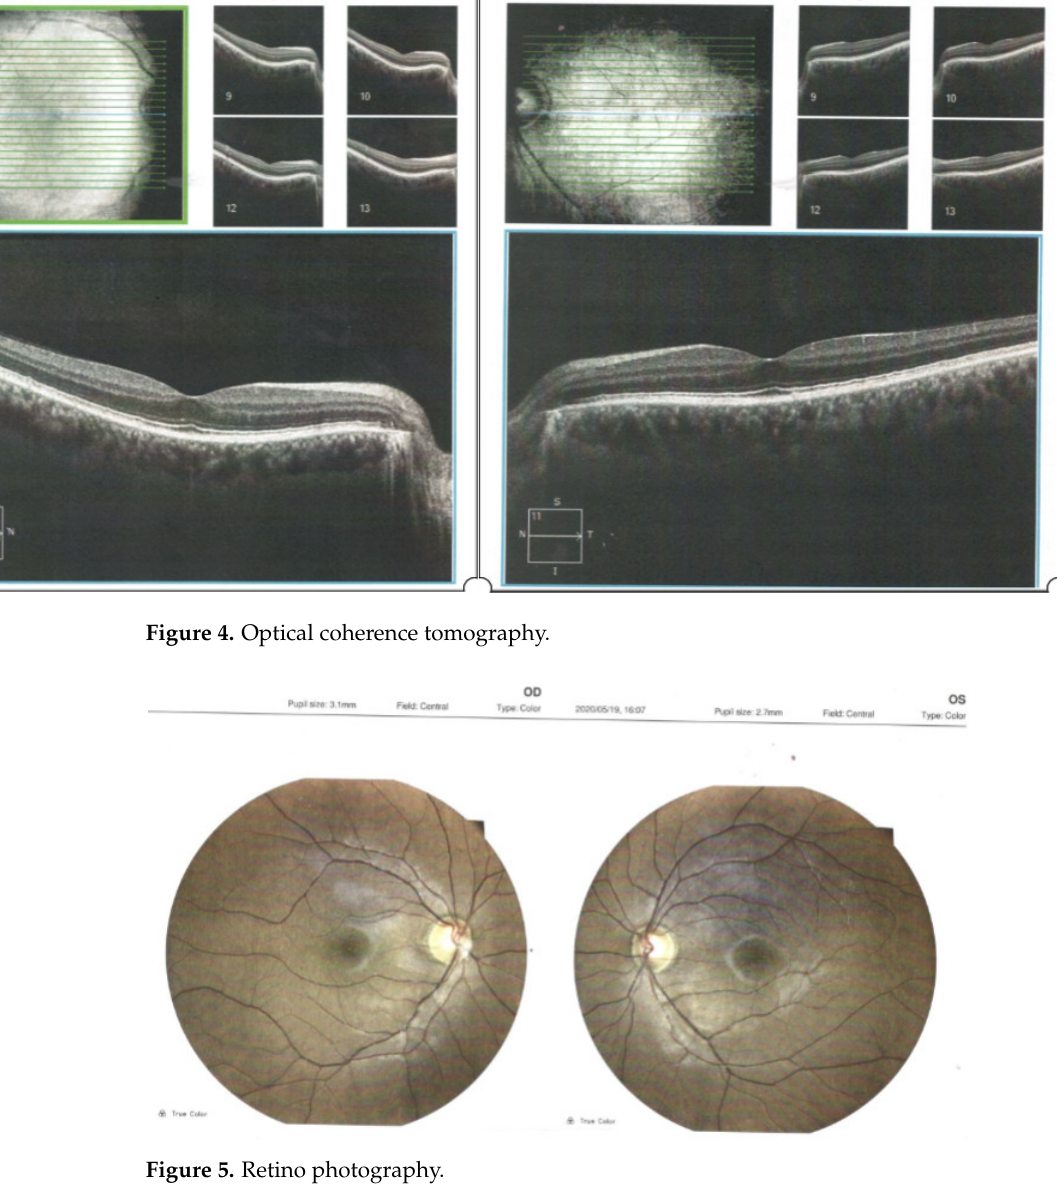
Figure 6. ONH and RNFL analyses.